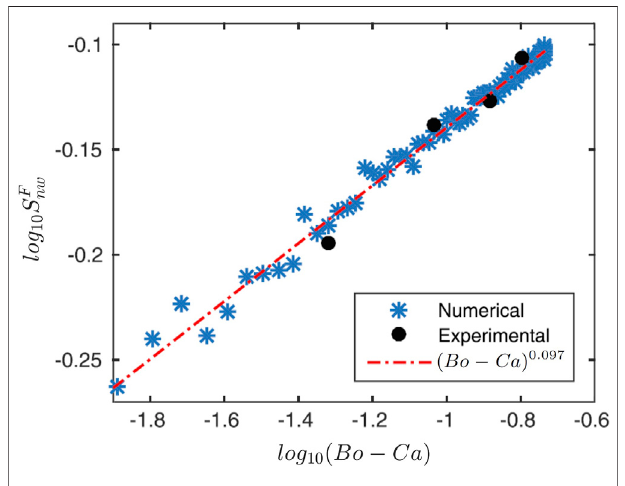
FIGURE 11 | The fi nal saturation as a function of the generalized Bond number Fa /( c N ( p c )) (cid:1) Bo − Ca isplottedbothforexperimental(blackdots)and numerical results (blue stars) produced via invasion percolation with a gravitational fi eld, together with the predicted result Eq. 49 (red dash- dotted line) in two dimensions. The capillary number Ca (cid:1) q μ 2 a 2 /( c kA ) (cid:1) 1.2 · 10 – 4 is kept fi xed while the Bond number Bo (cid:1) Δ ρ ga 2 / c is changed in the experiments. Numerical and experimental data from